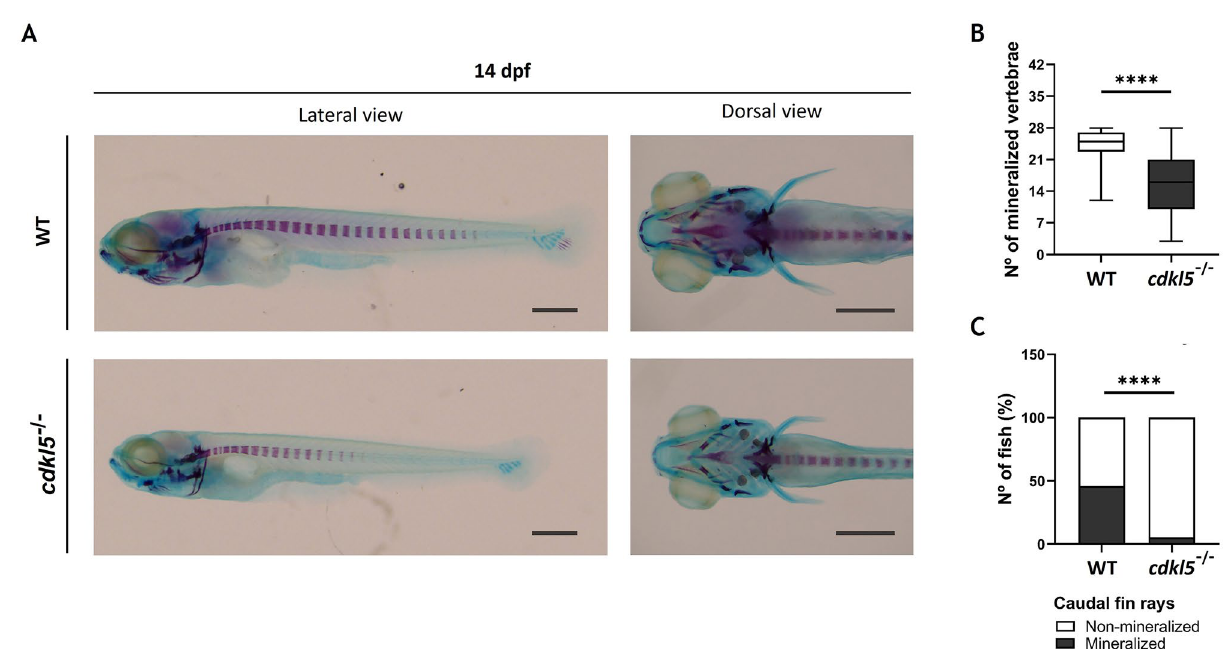
Figure 5. Skeletal development of cdkl5 sa21938 mutants with 14 dpf. ( A ) Representative images of the wild-type (WT) and homozygous ( cdkl5 -/- ) larvae double-stained with alcian blue and alizarin red. Scale bar = 0.5 mm. ( B ) Number of mineralized vertebrae in cdkl5 −/− (n = 58) and WT (n = 54) larvae. Values are represented as median with interquartile range. Statistical analysis was performed using Mann–Whitney. ( C ) Percentage of fish with mineralized caudal fin rays. Statistical analysis was performed using the Chi-square test. **** indicate p <